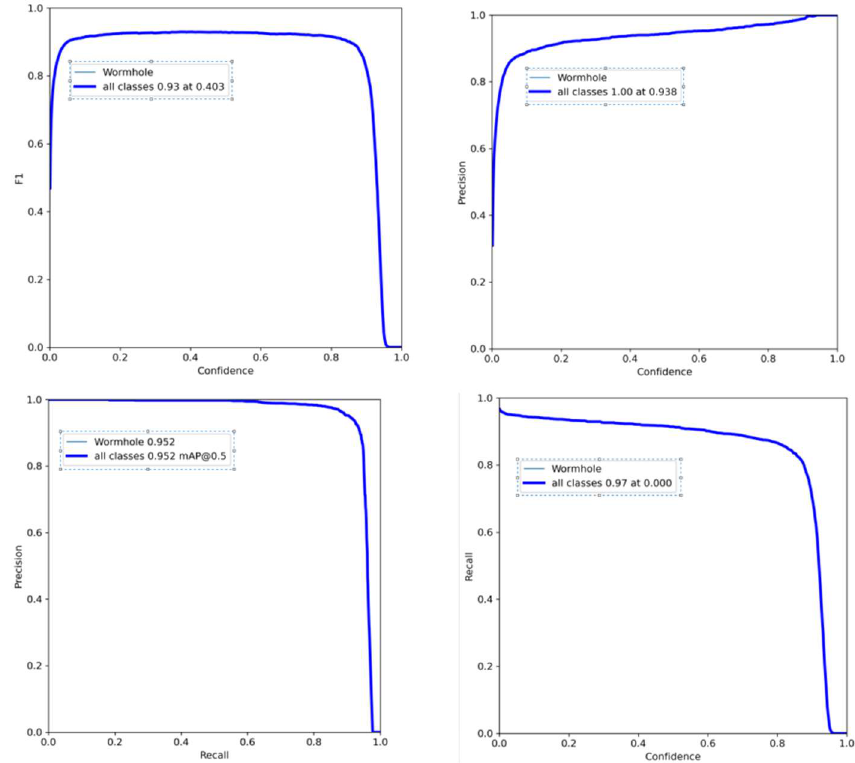
Figure 5. CCA-YOLO model training process.